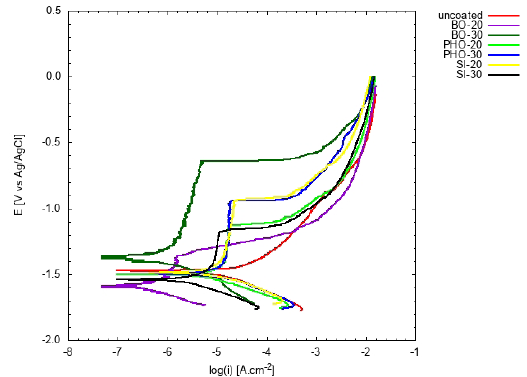
Figure 10. Potentiodymamic polarization curves of the uncoated and anodized AZ61 alloy in 0.1 M NaCl solution at room